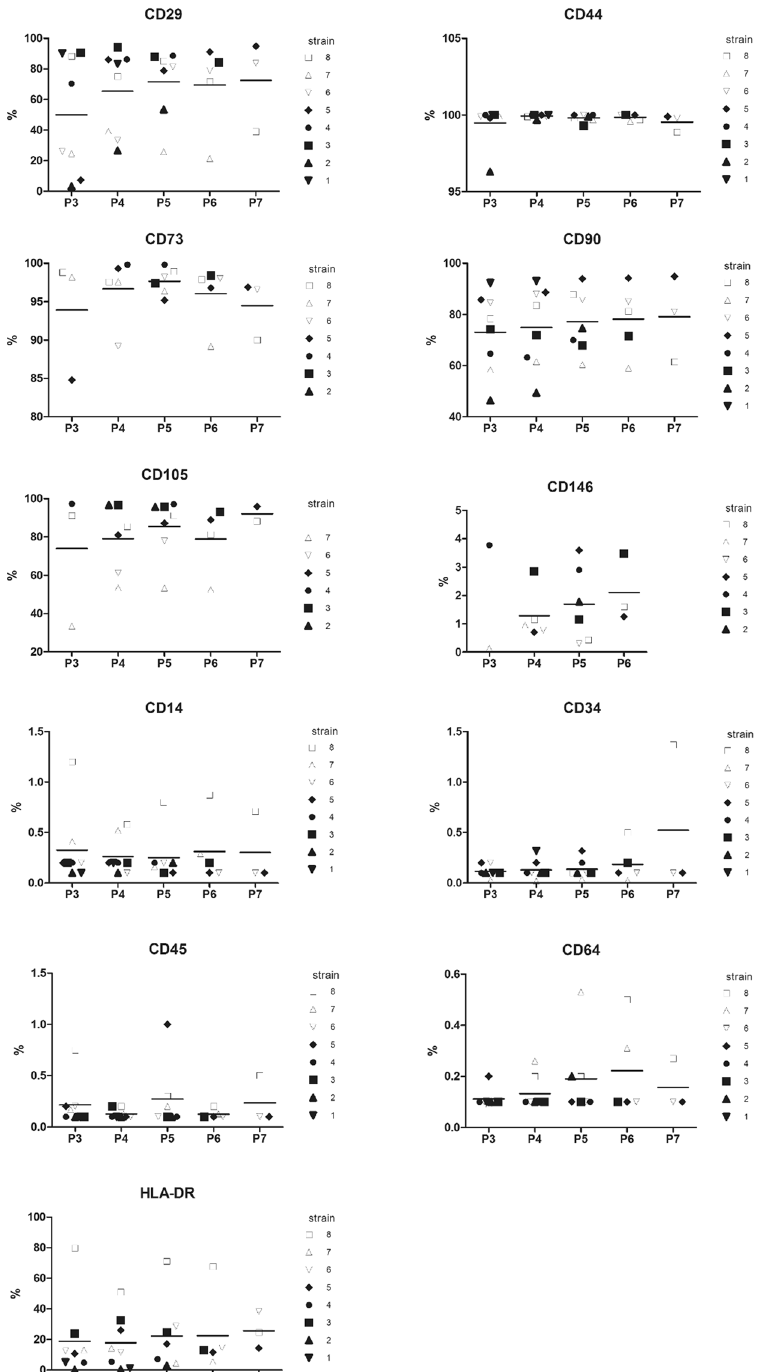
Figure 1. Immunophenotype of hBM-MSCs. The expression of CD29, CD44, CD73, CD90, CD105, CD146, CD14, CD34, CD45, CD64, and HLA-DR was analyzed by flow cytometry in hBM-MSC preparations from eight donors between passage 3 and 7 (n = 8). The graphs show the percentage of positive cells relative to an isotype control depending on the strain and passage. The means are represented by a bar for each